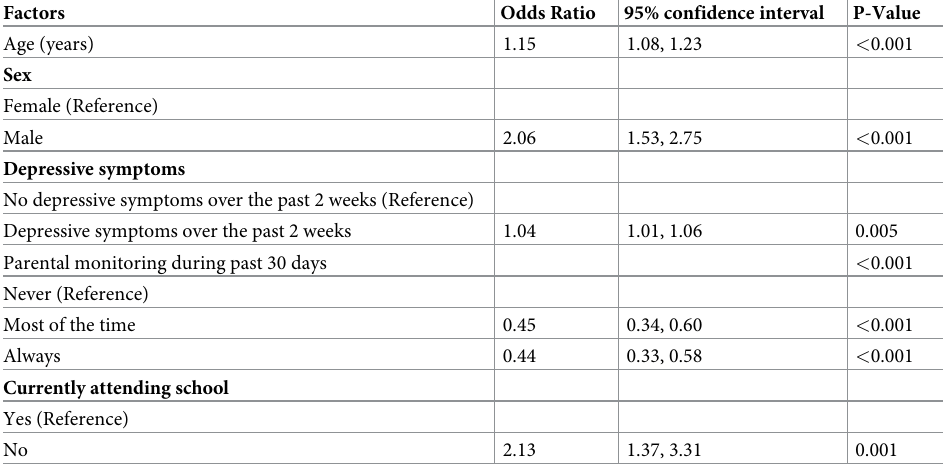
Table 4. Factors associated with membership to behavioral clusters from multivariate stepwise ordinal logistic regression (n = 1,058).